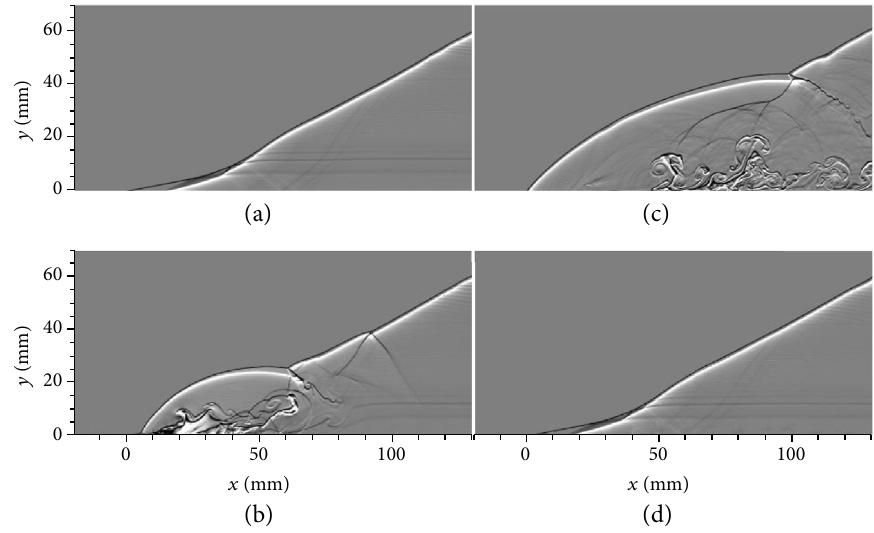
Figure 10: Evolution of the fl ow fi eld after DJFD of 500 Δ t at θ = 30 ∘ . (a) t = 0 (original steady state), (b) t = 500 Δ t (the jet fl ow has just been turned o ff ), (c) t = 700 Δ t , and (d) steady state after the